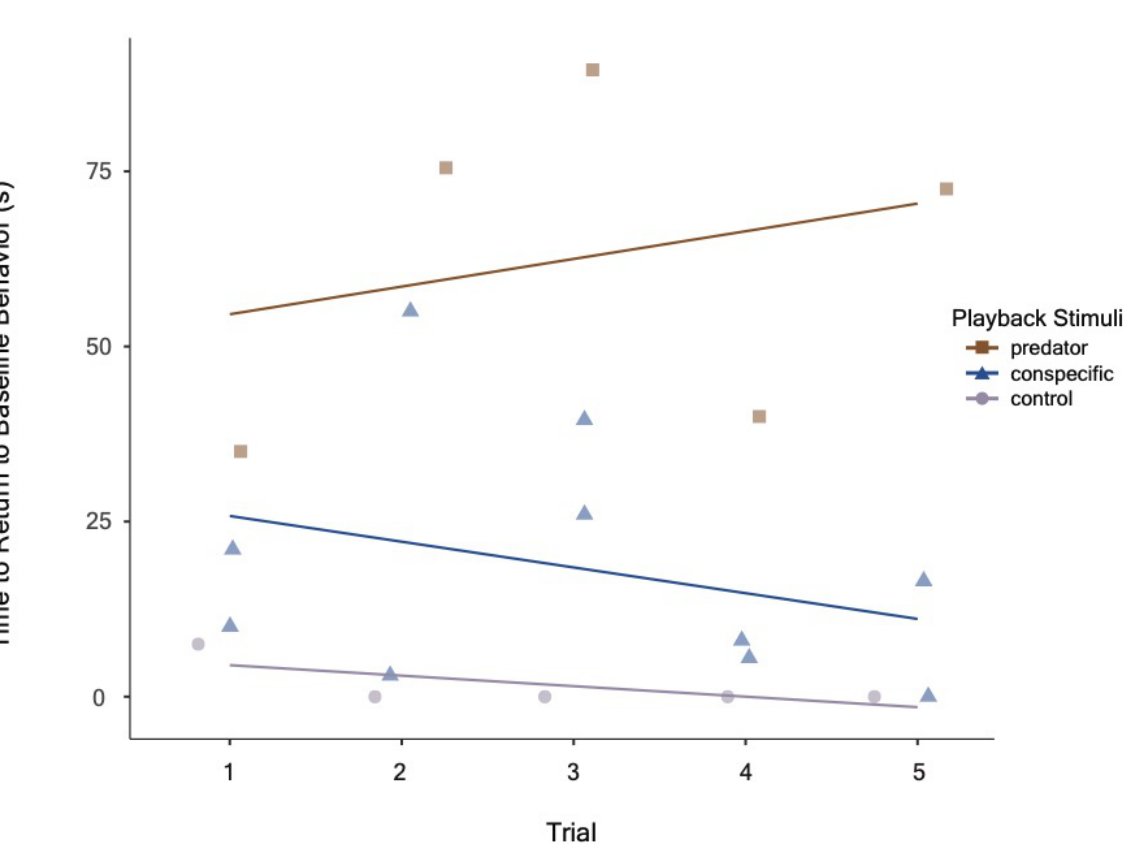
Latency in Response to Playback Stimuli over the Test